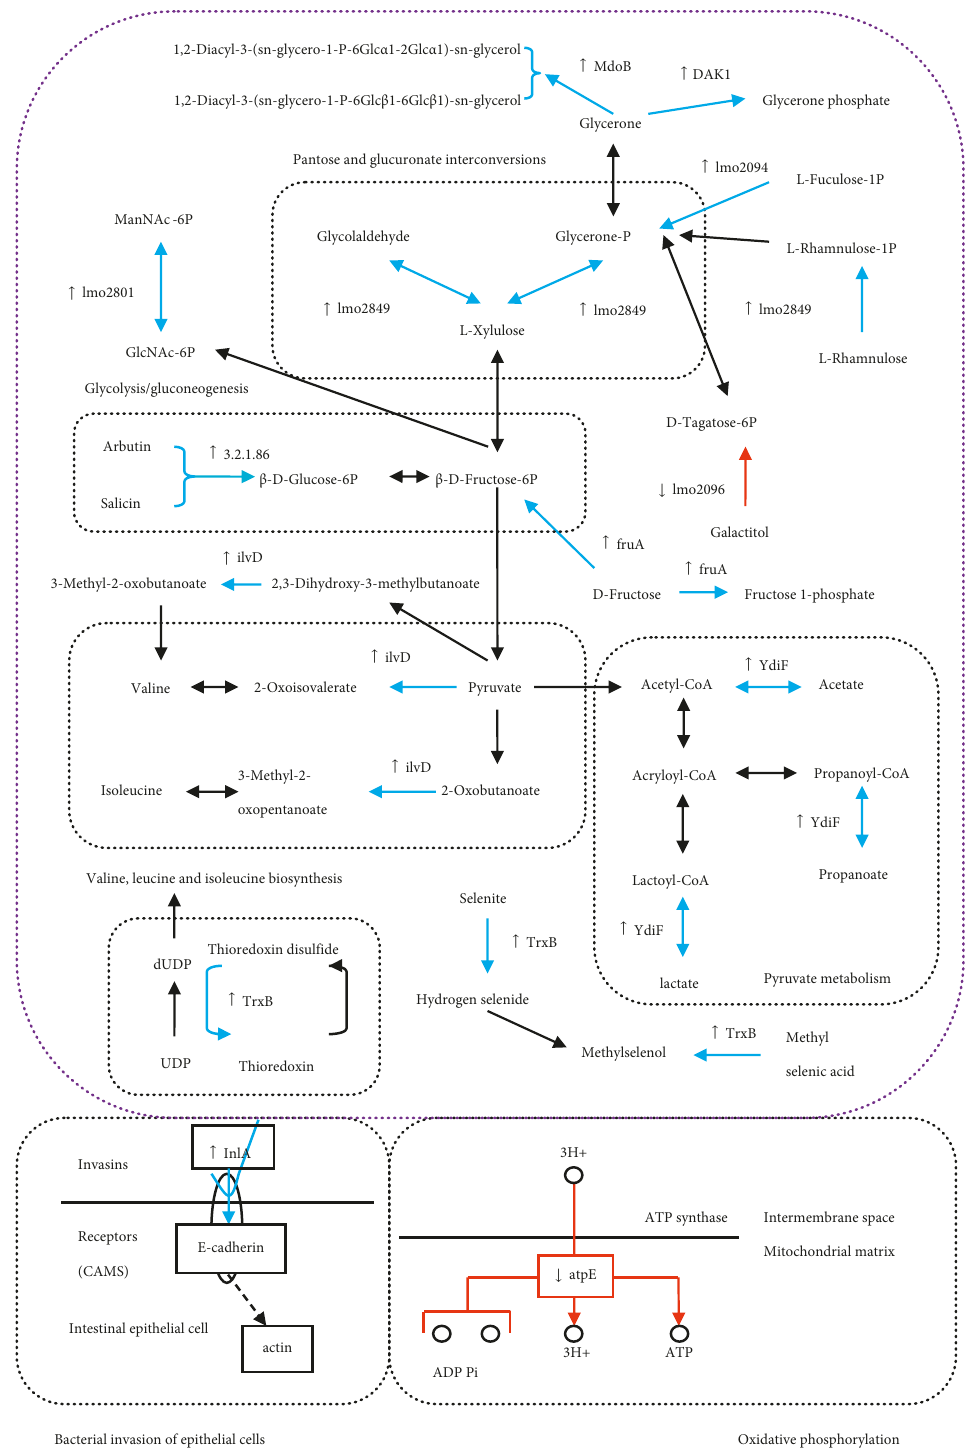
Figure 4: Metabolic map of intermediary metabolism of L. monocytogenes ATCC 19115 under nongrowth permissive acidic and hyperosmotic conditions of pH 3.5 and a w 0.90. The map was constructed from spectral abundance data and demonstrates relative abundance of pathway components during inactivation and support data related to accumulated metabolic end-products. Pathway as- signments of proteins are based on information from the KEGG database. Blue arrows indicate significant increases, and red arrows represent significant decreases in log ratio of the fold change in protein abundance proteins related to each pathway with the sampling time at 5 min, 30min, and 1 hr at 25 ° C for a time-course